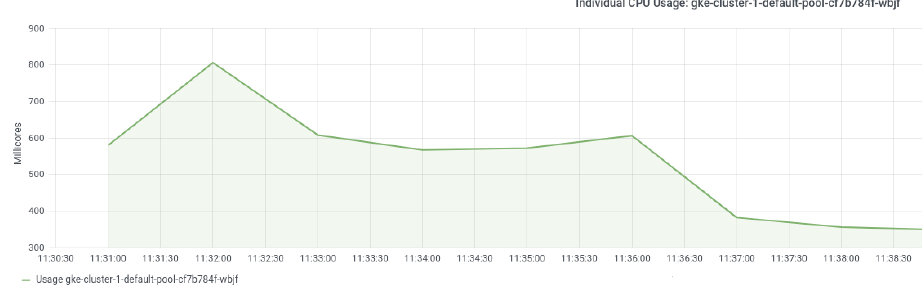
Figure 13. Cassandra node CPU usage when reconfiguring.